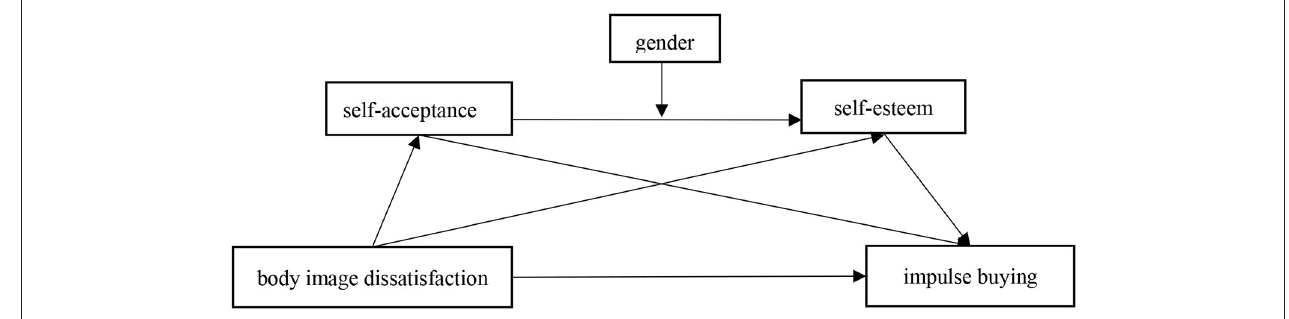
FIGURE 1 | Conceptual